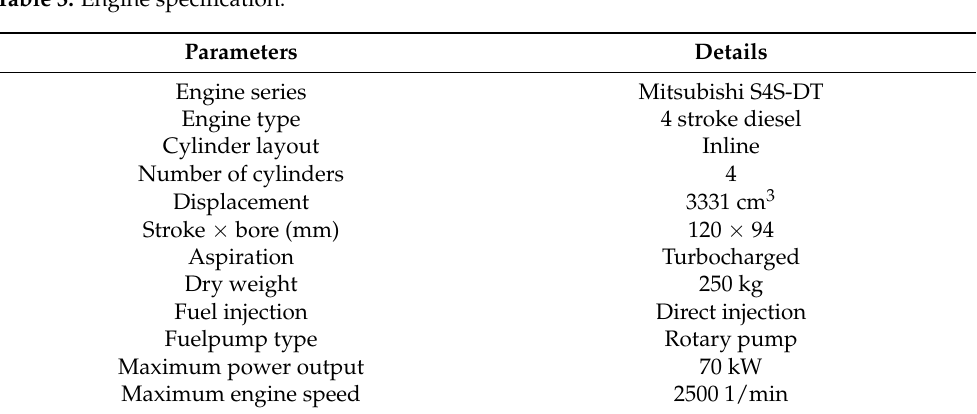
Table 3. Engine specification.